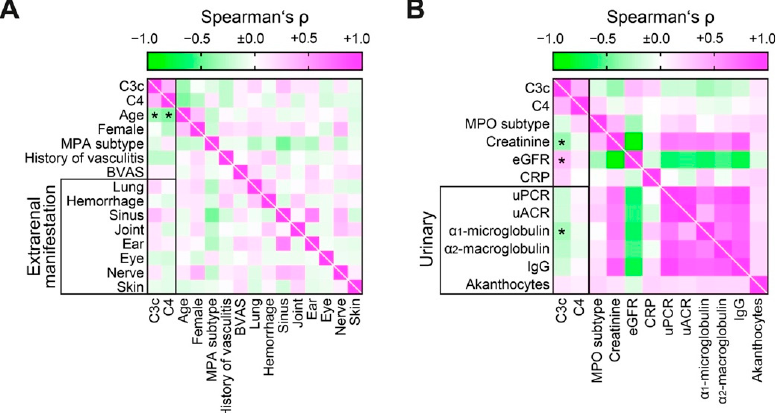
Figure 3. Low levels of circulating C3c correlates with AKI severity in ANCA GN independent of systemic disease activity or extrarenal AAV manifestation. ( A ) Circulating levels of C3c and C4 in association with clinical findings are shown by heatmap reflecting mean values of Spearman’s ρ , asterisks indicate p < 0.05. ( B ) Circulating levels of C3c and C4 in association with laboratory parameters are shown by heatmap reflecting mean values of Spearman’s ρ , * asterisks indicate p < 0.05. Abbreviations: AAV, ANCA-associated vasculitis; ANCA, anti-neutrophil cytoplasmic antibodies; BVAS, Birmingham Vasculitis Activity Score; C3c, complement factor 3 conversion product; C4, complement factor 4; eGFR, estimated glomerular filtration rate; IgG, immunoglobulin G; MPA, microscopic polyangiitis; MPO, myeloperoxidase; uACR, urinary albumin-to-creatinine ratio; uPCR, urinary protein-to-creatinine ratio.